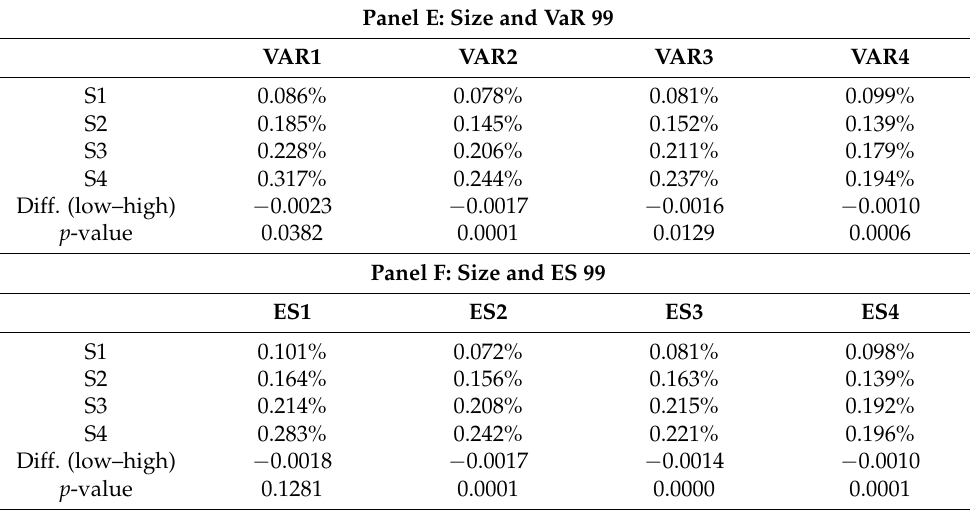
Table 5. Portfolio returns of size, VaR and ES at 99% level of significance. The table represents the average returns of 24 portfolios formed oversize and VaR and 24 portfolios assembled oversize and CVaR. A total of 527 listed firms is analyzed, from which we dropped firms with negative book-to-market equity. Firms with missing values and no data were dropped. S1 to S5 represents small to large portfolio stocks, VaR1 to VaR5 represents low VaR to High VaR stocks and ES1 to ES5 represents low to high expected shortfall stocks. Panel E: Size and VaR 99 VAR1 VAR2 VAR3